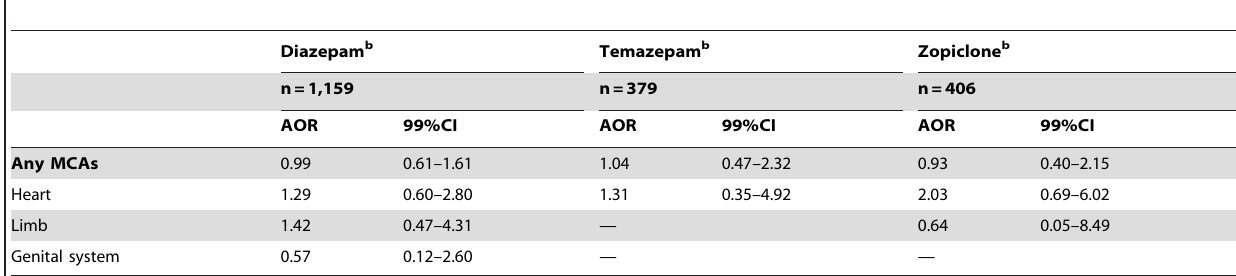
Table 5. Association between benzodiazepine prescribing in the first trimester of pregnancy and the risk of major congenital anomalies in offspring a